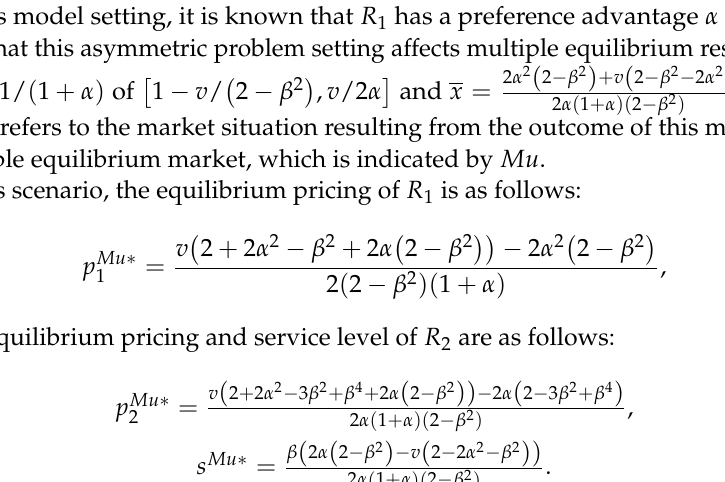
Fu β . Figure 1. The changing trends of β Fu 2 2